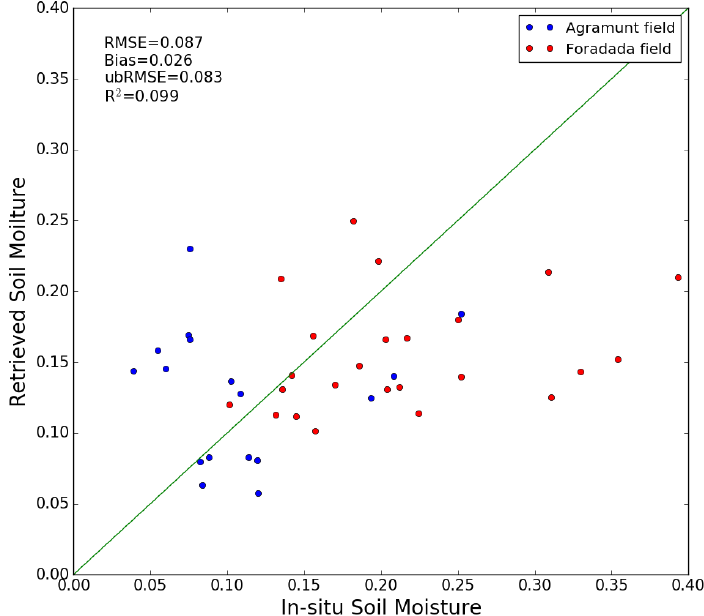
Figure 8. Intercomparison between ground measurements and S1 moisture estimations based on method 1, for the case of two demonstration fields, at Agramunt and Foradada.